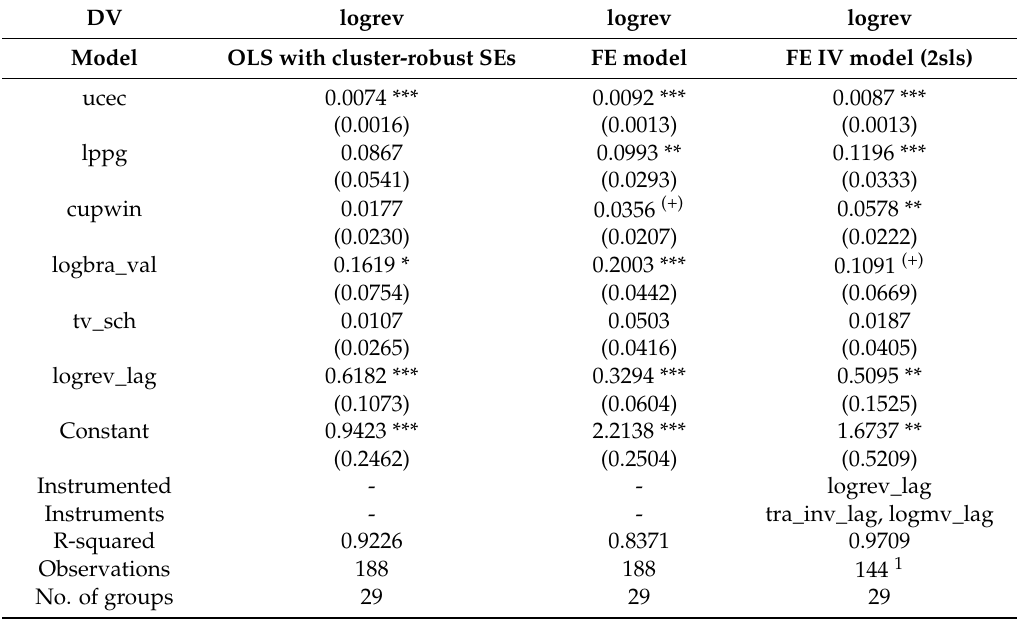
Table 8. Key regression results: financial